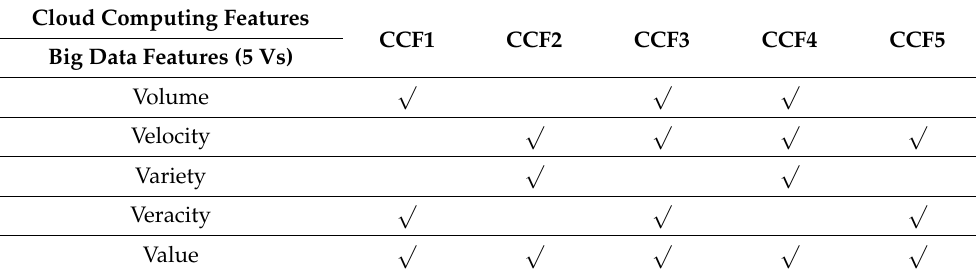
Table 2. Contributions of Big Data to Cloud Computing.